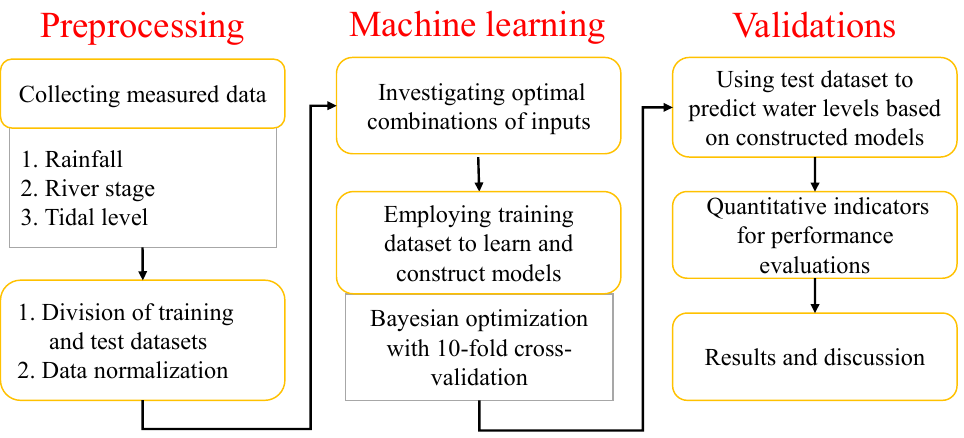
Figure 2. Primary flowchart for establishing data-driven models as well as predicting river stage.